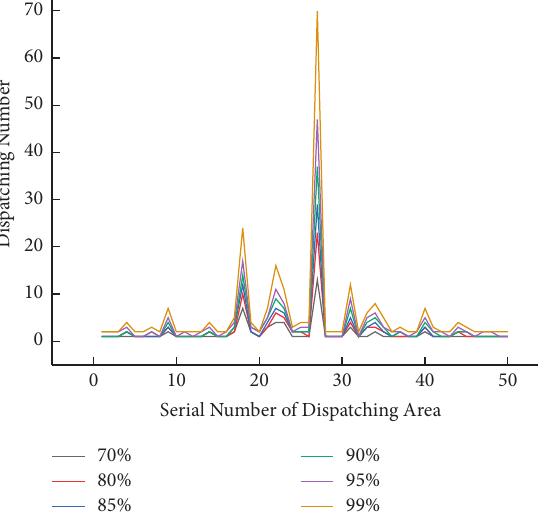
Figure 11: The dispatch quantities at different system reliability degrees within the different dispatch